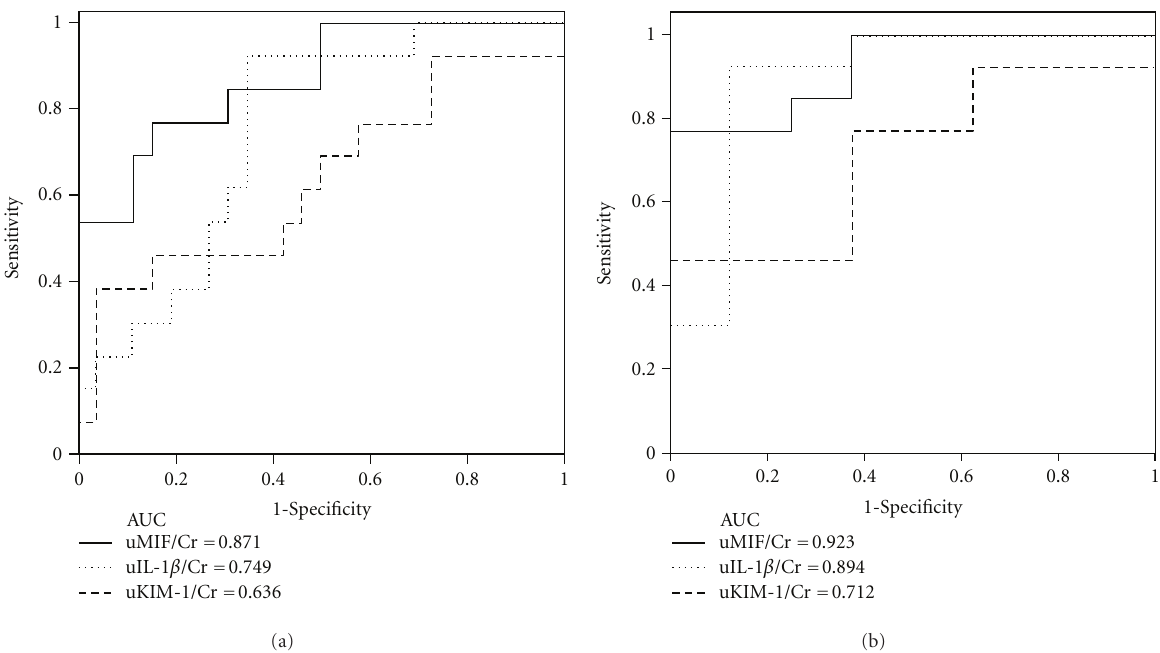
Figure 3: Urinary levels of MIF detected the presence of AKI in APN patients. The receiver operating characteristic curves for the laboratory parameters for the detection of AKI in all APN patients ( n = 39) (a) or in the subgroup with renal dysfunction (eGFR < 60 ml/min/1.73cm 2 , n = 21) (b). The AUCs of the urinary MIF, IL-1 β , and KIM-1 levels, which were normalized based on the urinary creatinine (Cr) levels, are